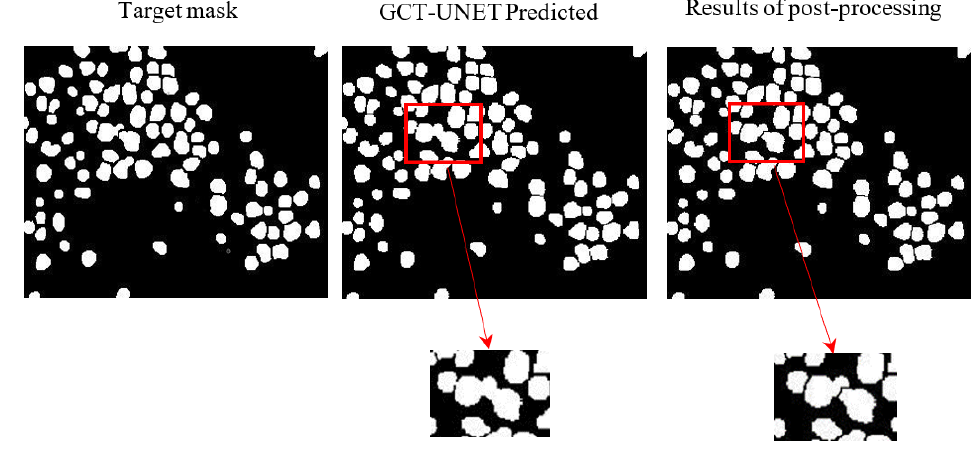
Figure 5. Compare the results of our model generation with the results of secondary segmentation.